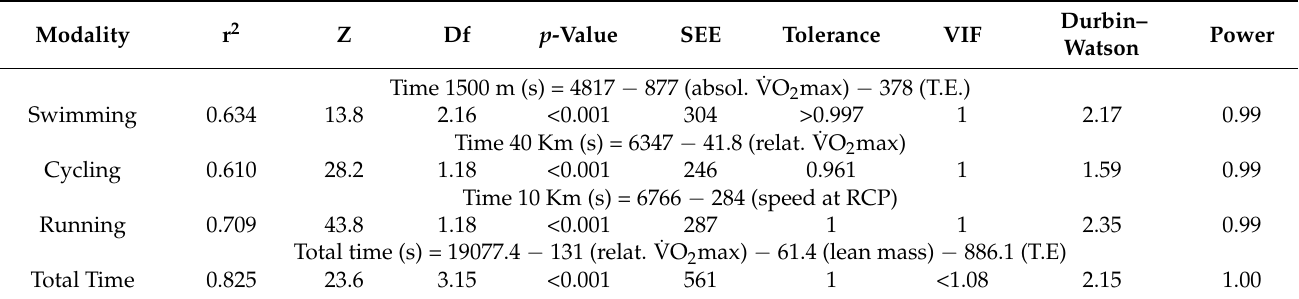
Table 4. Multiple linear regression models for estimating performance in swimming, cycling, running, and total race time for female athletes.